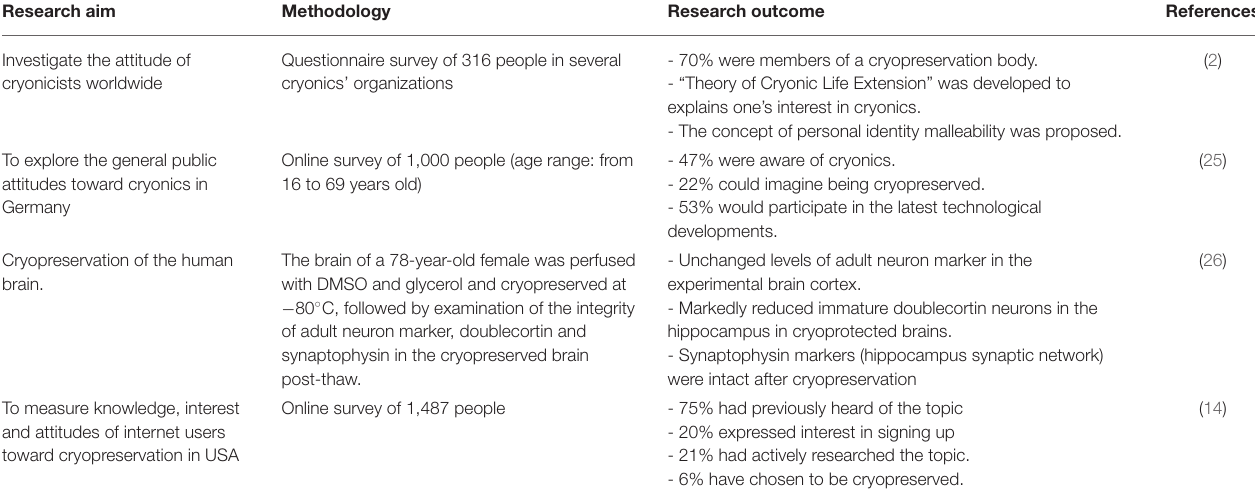
TABLE 1 | Summary of original research on